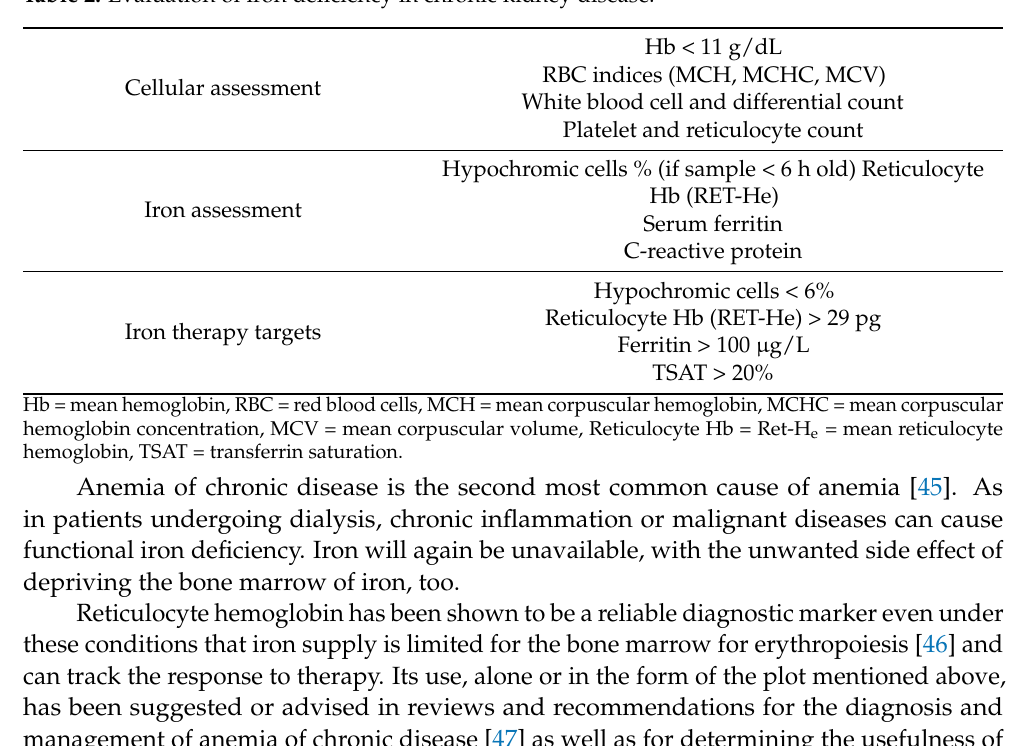
Table 2. Evaluation of iron deficiency in chronic kidney